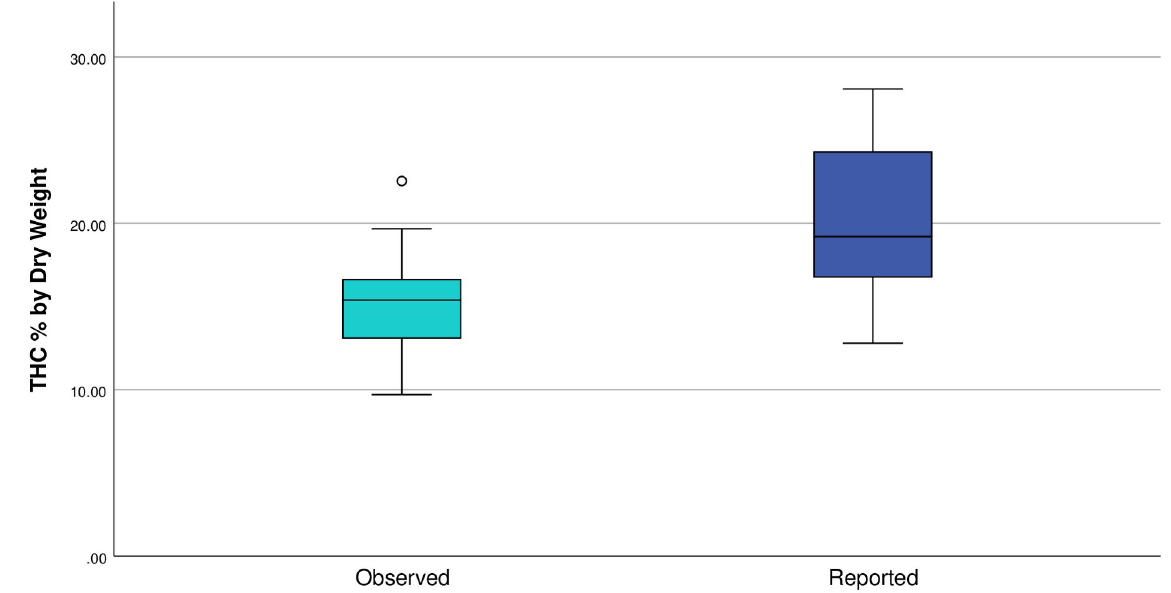
Fig 1. Box and whisker plot. Mean THC % by dry weight for observed (light blue) and reported values (dark blue). respectively (Table 1, Fig 2). Sixteen of 23 samples (69.56%) had observed values that were more than 15% lower relative to the lowest reported THC % by dry weight, and 13 of those samples (56.52%) were more than 30% lower than the reported value. When examining the highest reported value, 20 of 23 samples (86.95%) had observed values that were more than